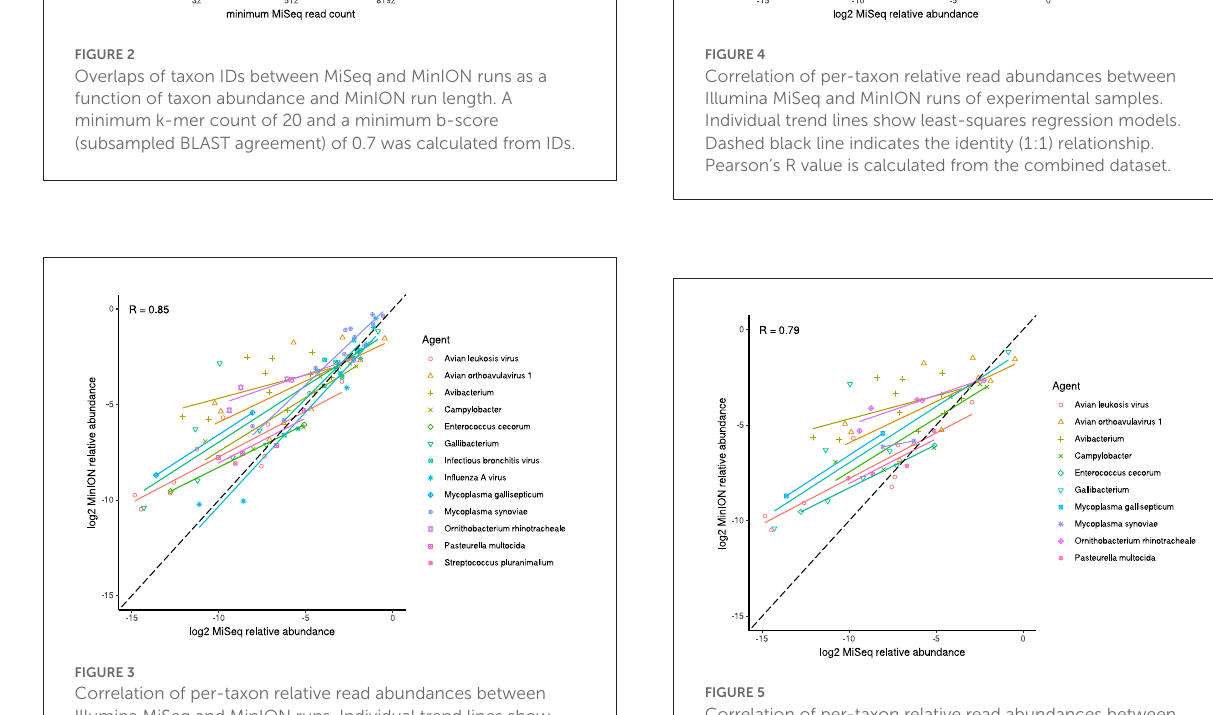
FIGURE5 Correlation of per-taxon relative read abundances between Illumina MiSeq and MinION runs of clinical samples. Individual trend lines show least-squares regression models. Dashed black line indicates the identity (1:1) relationship. Pearson’s R value is calculated from the combined